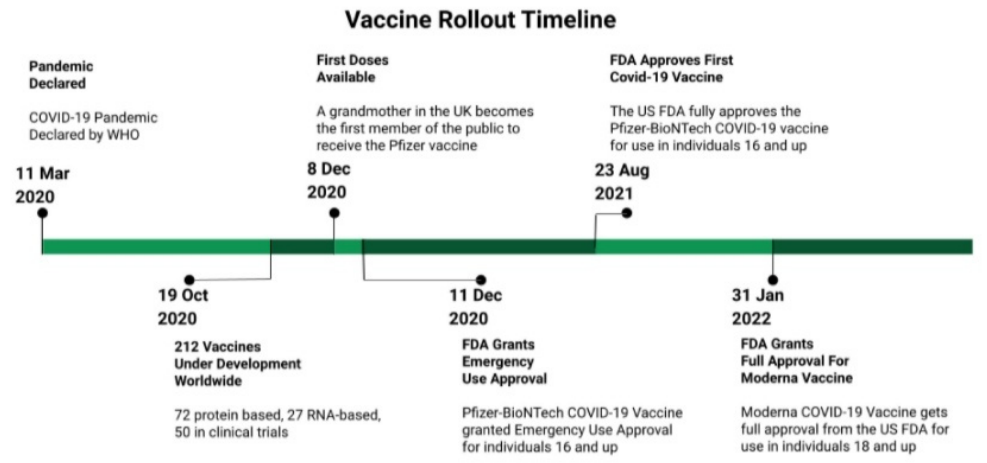
Figure 1. A brief timeline of selected events related to the vaccine rollout. Adapted with permission from Peterson et al. [6]. 2022, Christopher J.